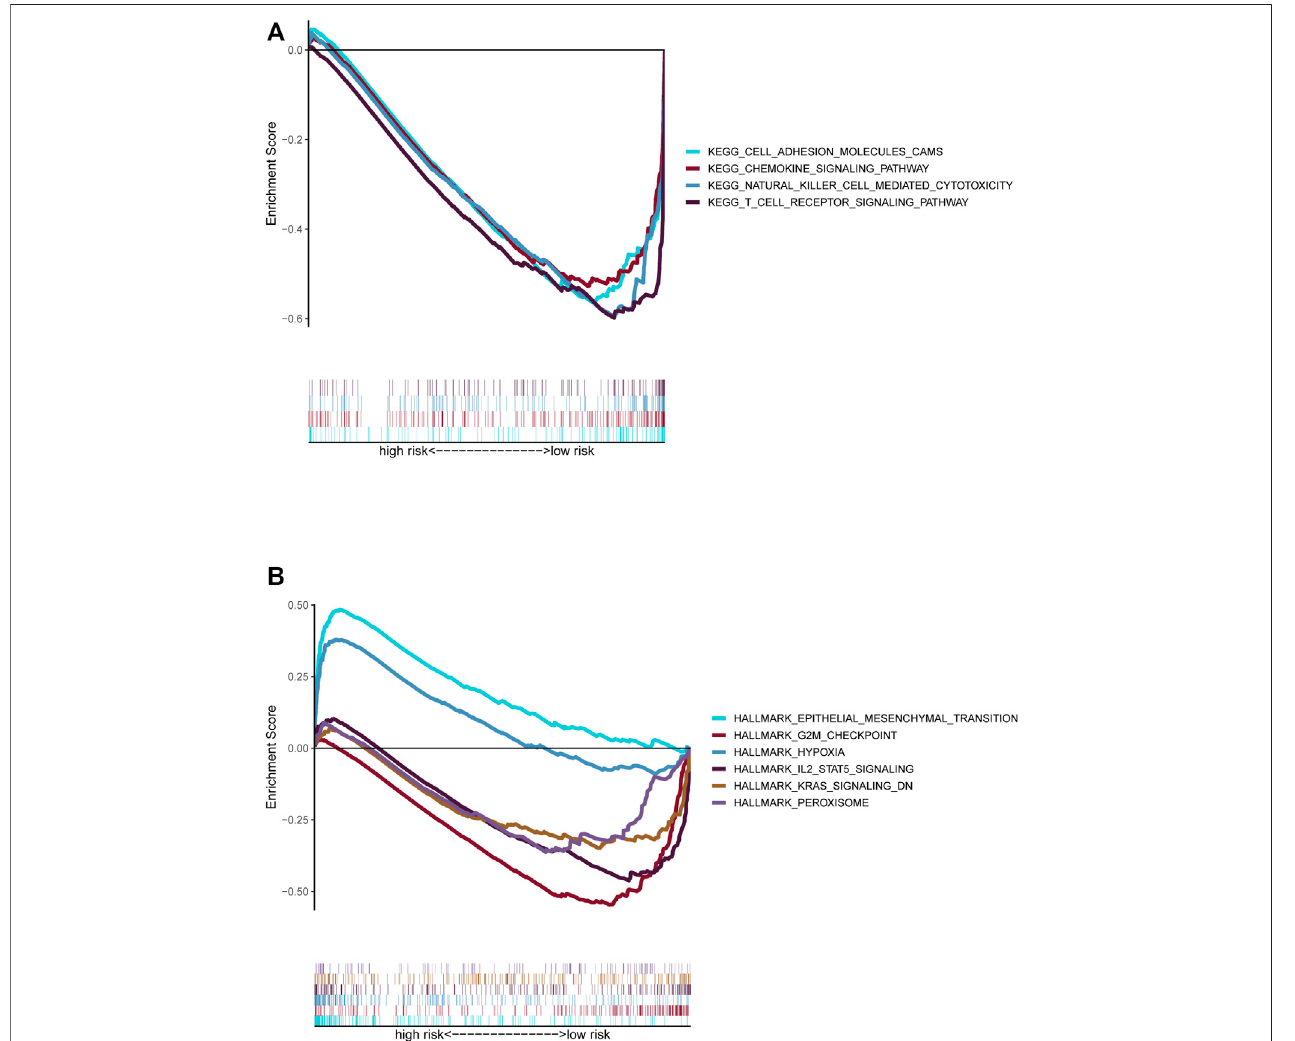
FIGURE 7 | Functional prediction of risk signature via GSEA. (A) . The KEGG pathway set was enriched between the high-risk and low-risk groups. (B) . The hallmark gene set was enriched between the high-risk and low-risk groups.